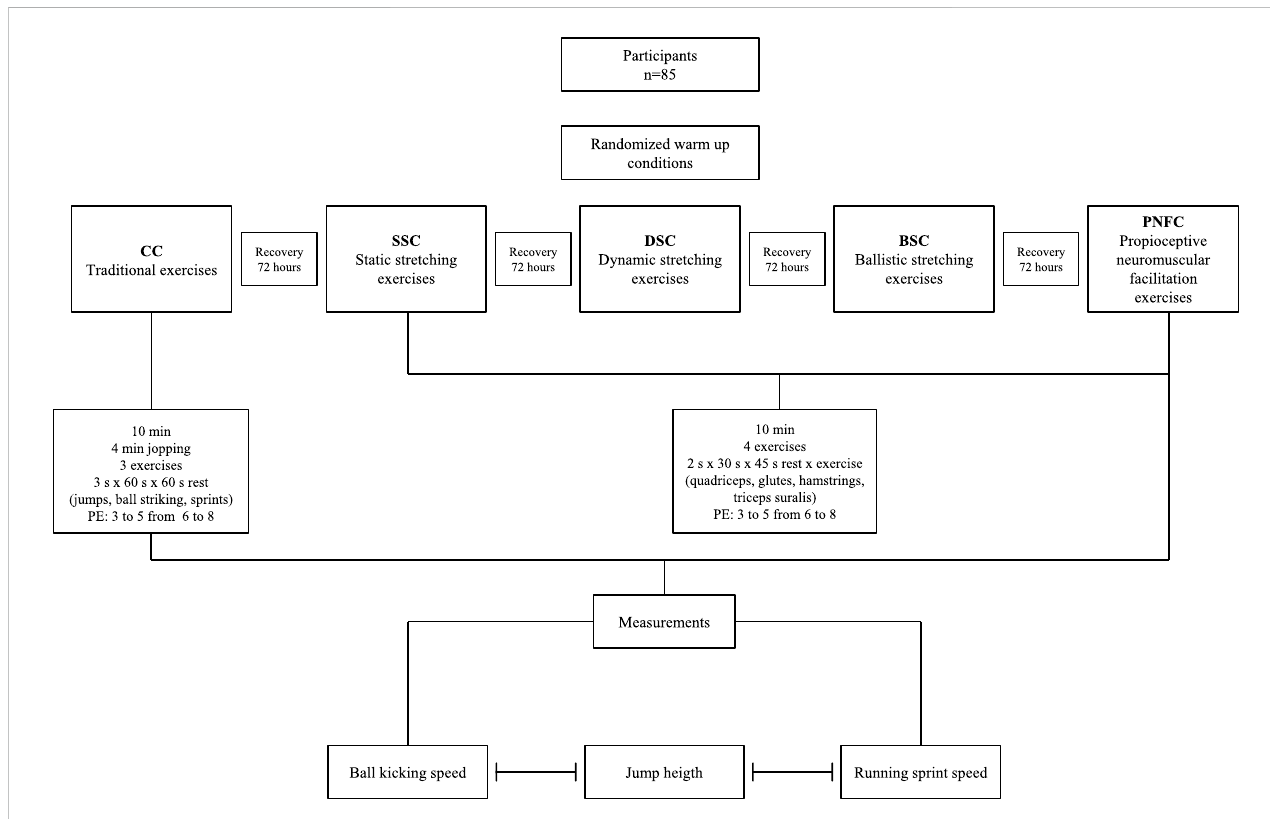
FIGURE 1 Study design. CC: control condition, traditional exercises (movements in different directions with progressive increases in speed). SSC: static stretching condition, static stretching exercises (static stretching movements with progressive increases in amplitude). DSC: dynamic stretching condition, dynamic stretching exercises (oscillatory stretching movements with progressive increases in speed). BSC: ballistic stretching condition, ballistic stretching exercises (hold 5 s elongated position than 5 s of oscillatory movement with progressive increments completing 30 s). PNFC: proprioceptive neuromuscular facilitation condition, neuromuscular facilitation exercises (passive stretching 10 s followed by 10 s of isometric contraction followed by 10 s of passive stretching with progressive increases in intensity). PE: perception of